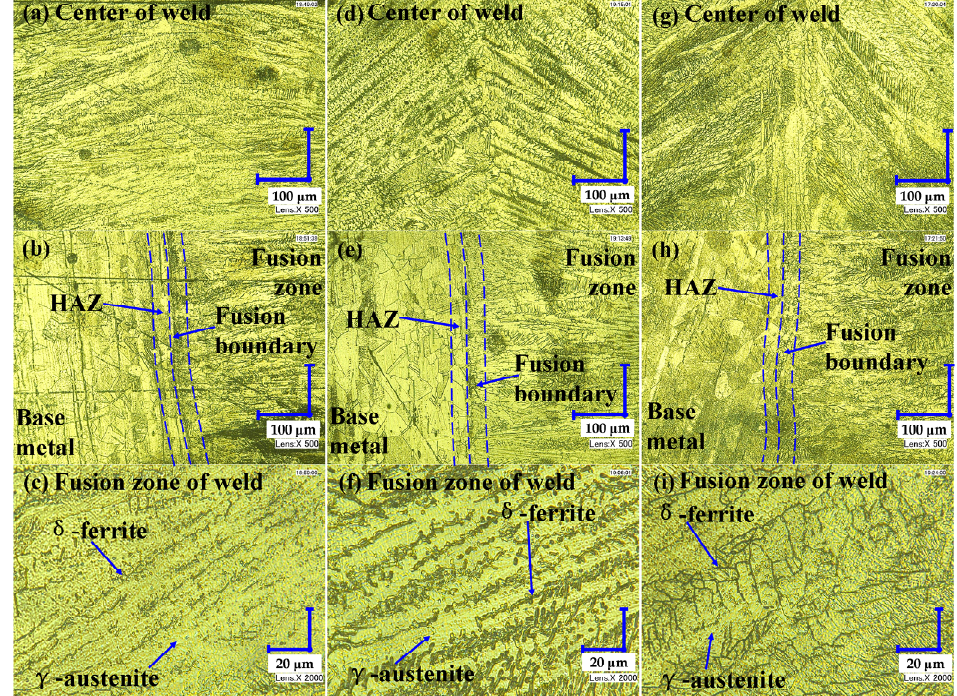
Figure 8. Microstructures of weld joints under different shielding gases: ( a – c ) were shielded by Ar; ( d – f ) were shielded by Ar + CO 2 ; ( g – i ) were shielded by CO 2 .